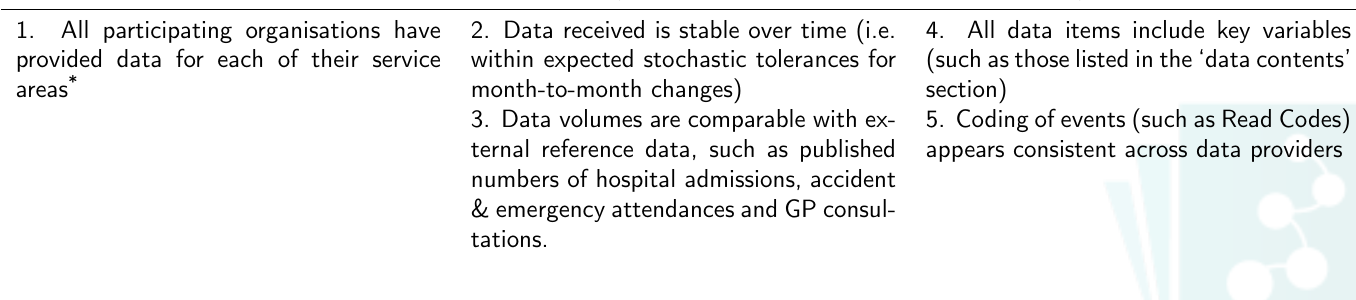
Table 1: Monthly data quality checks for the Kent Integrated